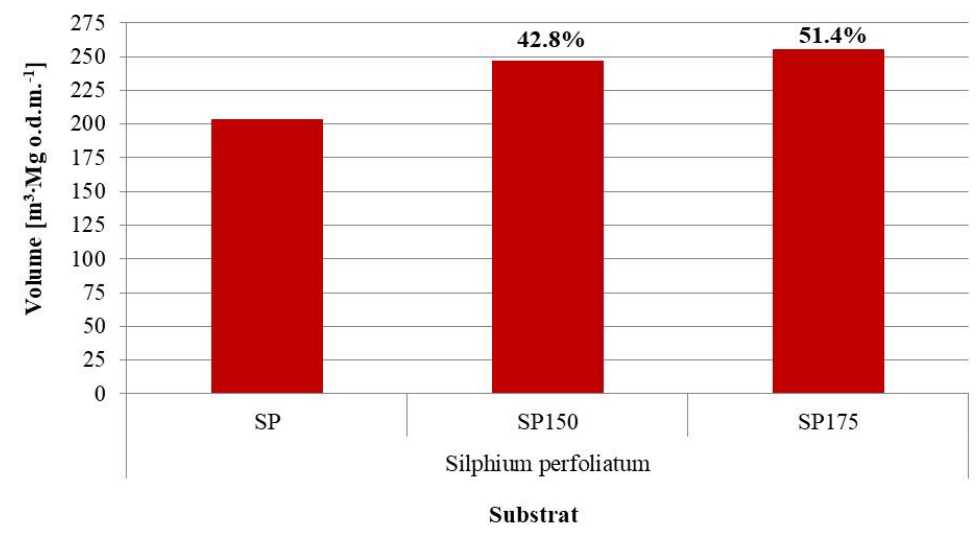
Figure 6. The cumulative methane production output from the non-extruded and extruded substrates per organic dry matter content.